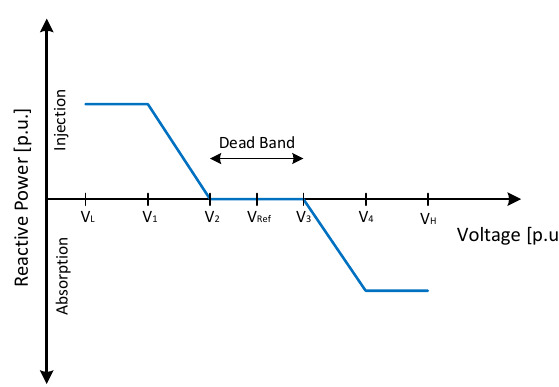
Figure 2. Generic Smart Inverter voltage-reactive power (Volt-VAR) Characteristics.